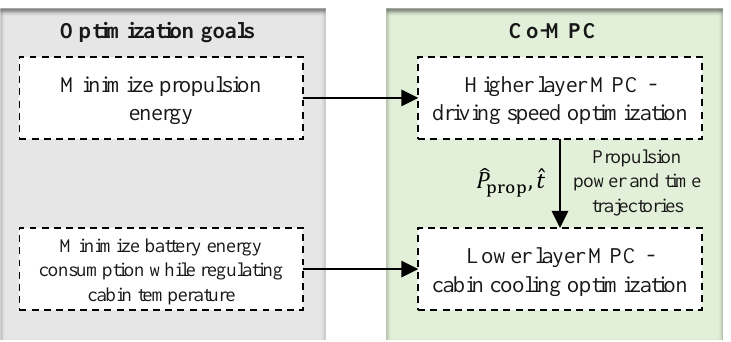
Figure 5. Control structure of the co-MPC. Two different optimization goals are selected for the higher-layer and lower-layer